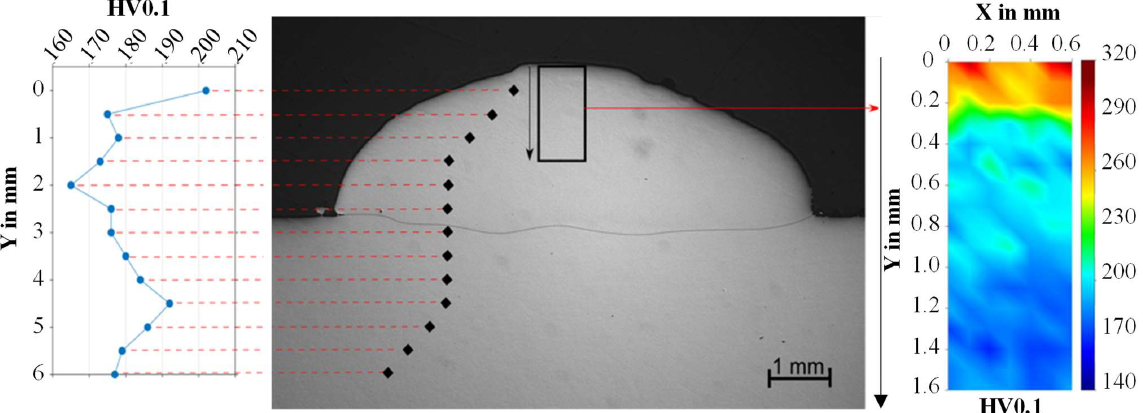
Figure 11. Cross-section and result of the hardness measurement of the sample tandem P4 (P4, I1 = 180 A, I2 = 90 A).